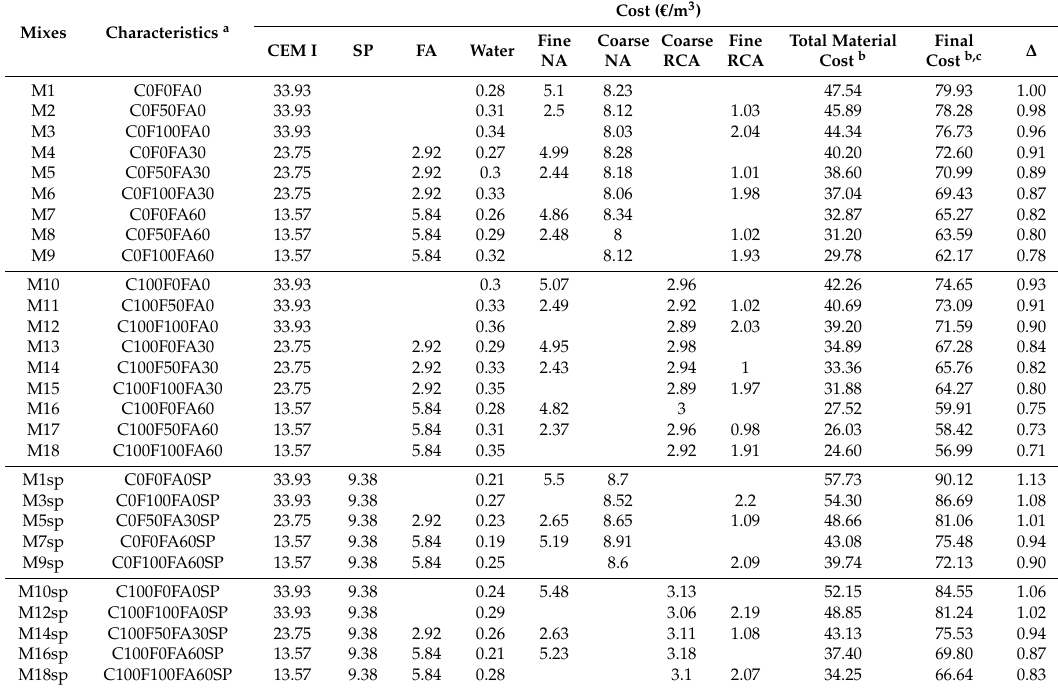
Table 4. Cost of 1 m 3 of each concrete